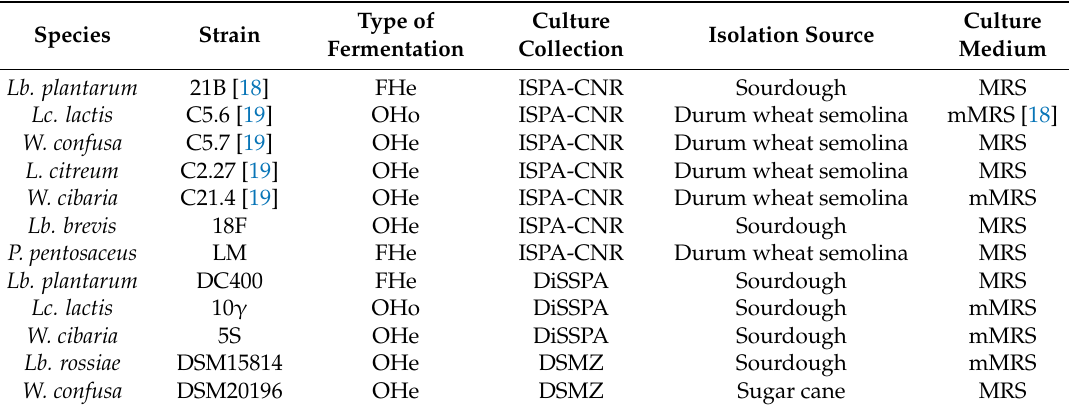
Table 1. Strains used and their corresponding